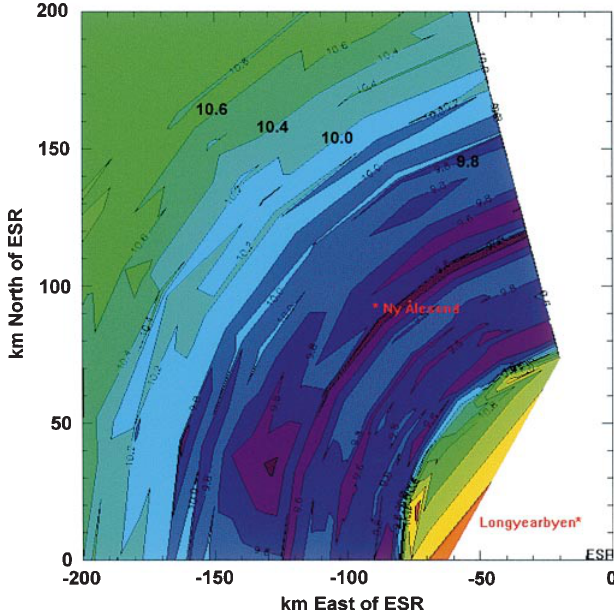
Fig. 3. Average electron density (or rather backscattered power calculated as electron density assuming scattering process is incoher- ent scatter) for 19 November, 1997. Axes denote horizontal distance from ESR. The radar operated at an elevation of 45 (cid:176) such that the horizontal range on the plot is identical to the measurement altitude. Period of measurement was 1645-2300 UT. Contours are labelled in